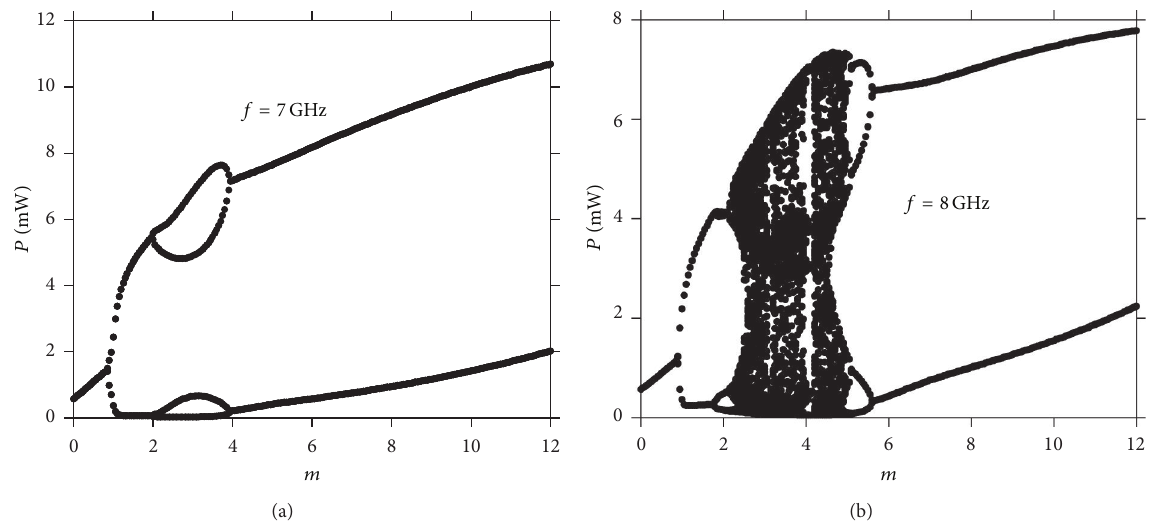
Figure 3: The laser bifurcation diagrams for different modulation